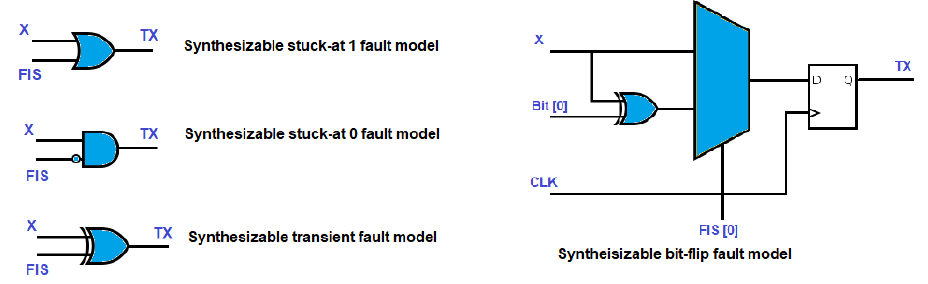
Figure 12. Synthesizable fault models. Table 4. Duty-value change used for different experiment sequences.